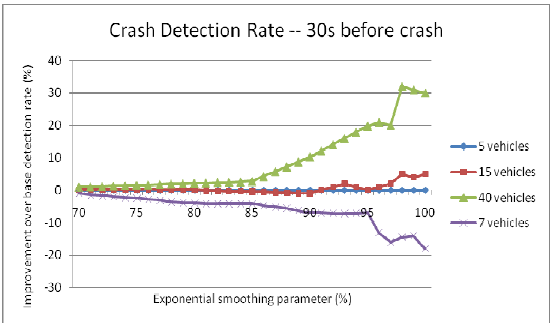
Figure 3. At 30s before crash, Detection Rate is compared across values of moving average of vehicles (base